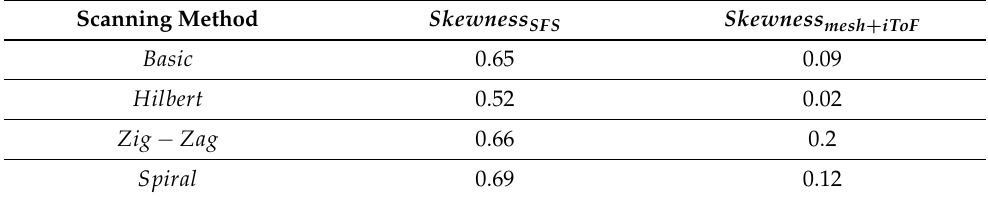
Table 4. Three-dimensional (3D) images perception of surface qualities without fog conditions calculating the skewness.